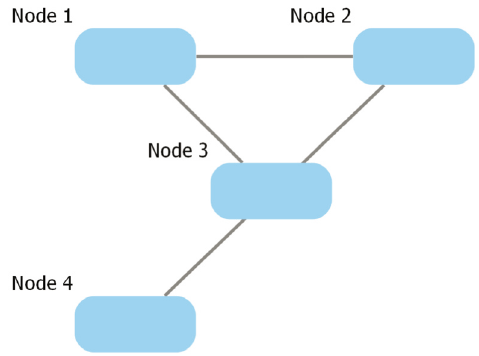
Figure 7. A network exported with the “External” option for node label